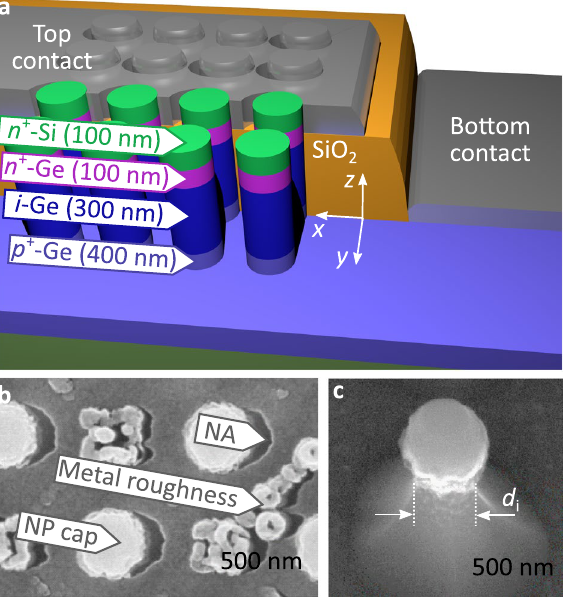
Figure 4. ( a ) 3D sketch of the NP-PD device. Metallization and passivation are partly removed. ( b ) Scanning electron microscopy (SEM) top view image of the device. ( c ) SEM image of a single NP after etching and before hardmask